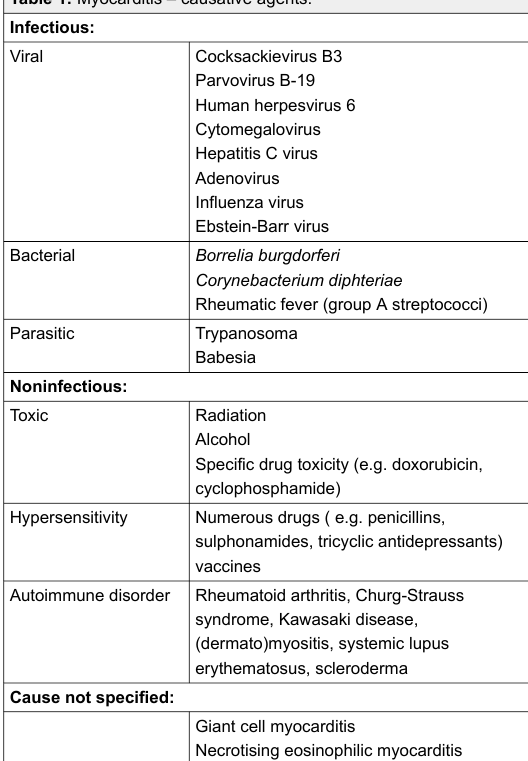
Table 1: Myocarditis – causative agents.